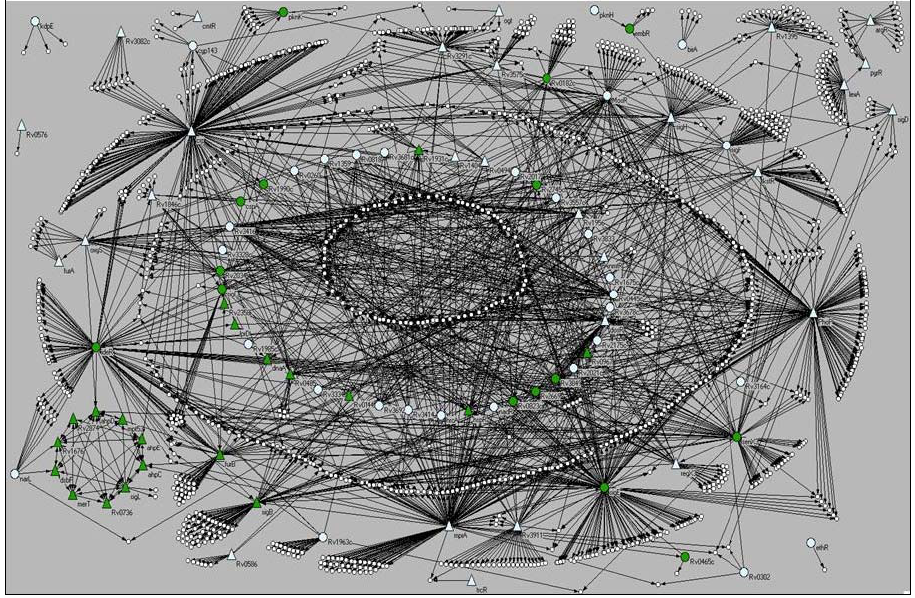
Figure 1. The Transcriptional-Regulatory (ETR) Network of M. tuberculosis . Nodes represent Mt ’s genes, and links represent their regulatory interactions. Approximately 35% of the genome is covered by this network (Modified from